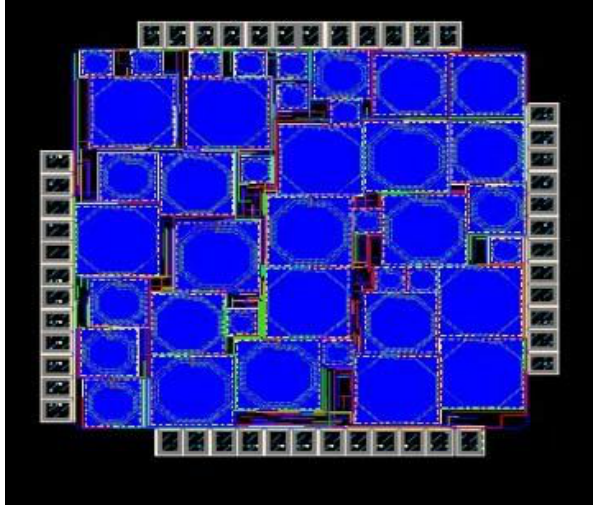
Figure 19. Designed Mixer Layout.